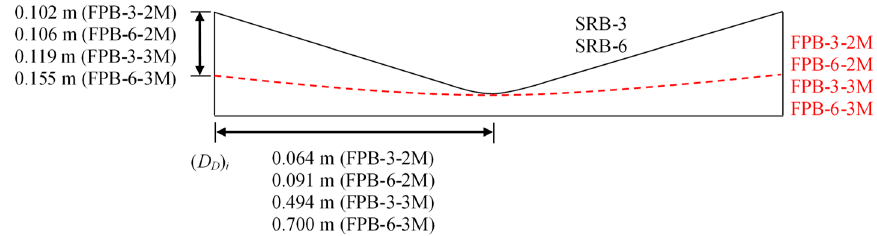
Figure 10. Illustrations of design criteria for FPB models.